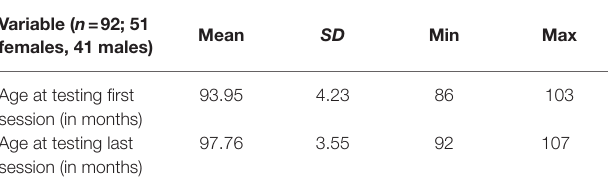
TABLE 1 | Mean age, standard deviation and range at first and last testing session. Variable ( n = 92; 51 females, 41